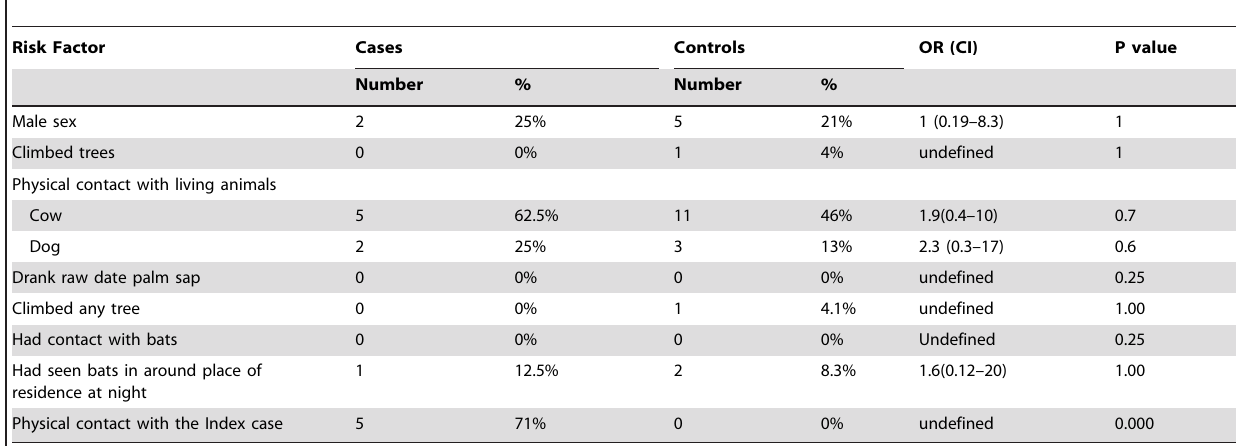
Table 2. Bivariate analysis of risk factors for Nipah infection, Sadar Upazila, Kushtia District, Bangladesh, March-April 2007.